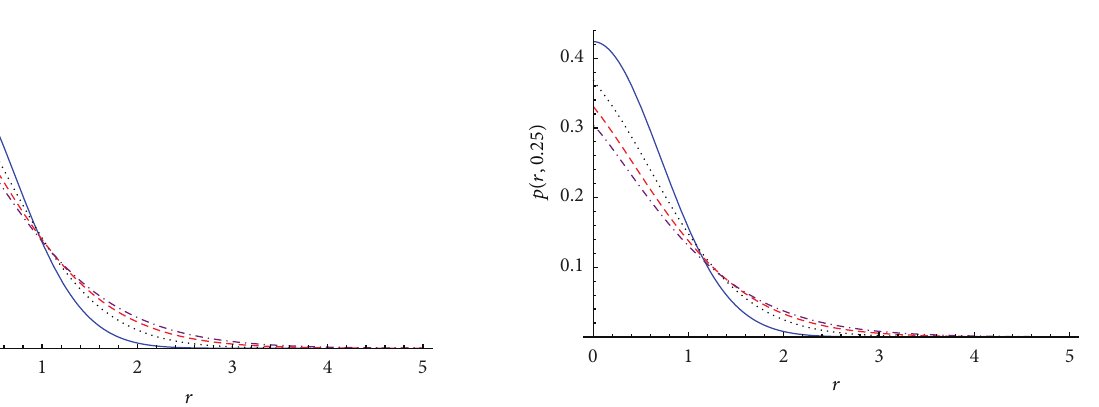
Figure 3: Curves of 𝑝(𝑟,0.25) versus 𝑟 for 𝑑 𝑓 = 1.5 and for 𝑑 𝑤 = 2 (solid line), 𝑑 𝑤 = 2.5 (dot line), 𝑑 𝑤 = 3 (dash line), and 𝑑 𝑤 = 3.5 (dot-dash line).